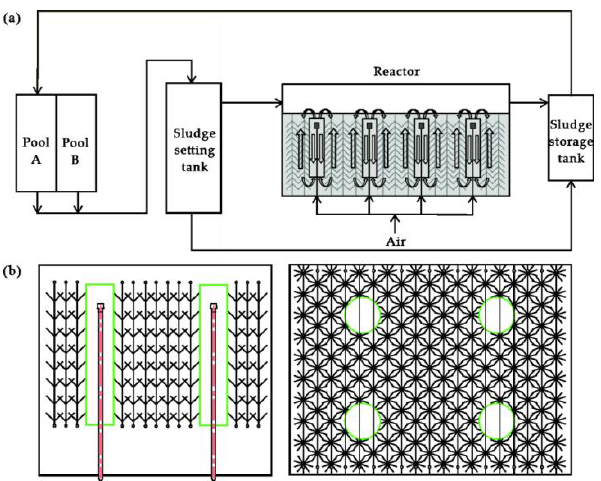
Figure 1. Schematic diagram of the ALBR and function-enhanced microbe system. ( a ) Schematic diagram. ( b ) Elastic solid filler.